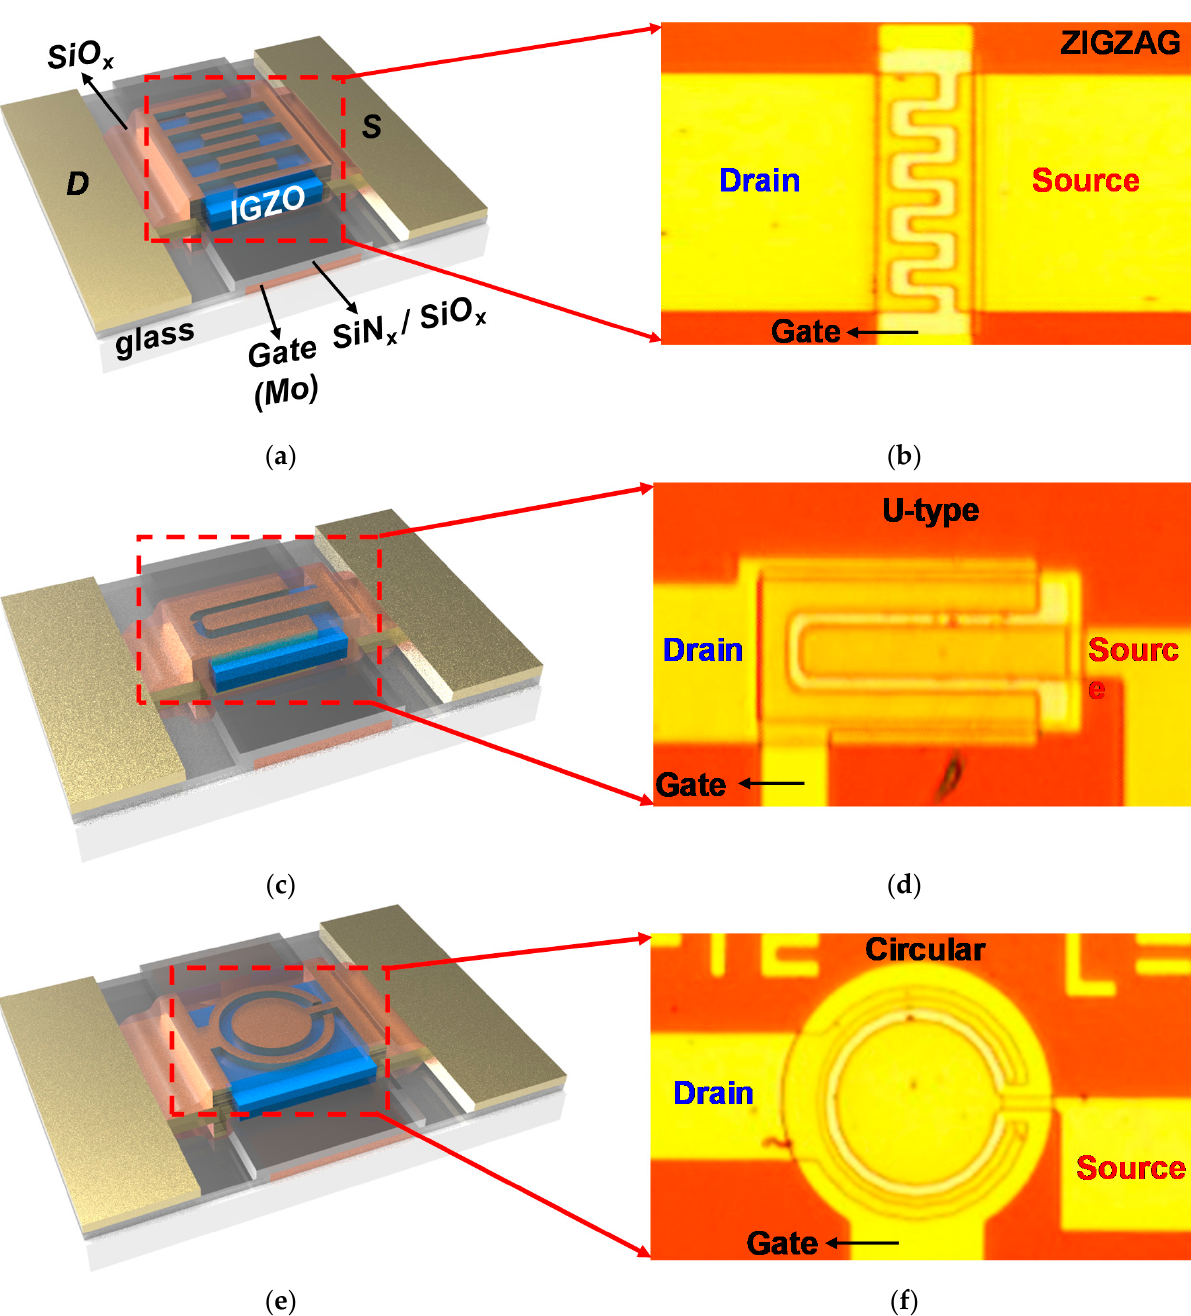
Figure 1. Schematic cartoons for the device configuration corresponding to ( a ) zigzag, ( b ) U-type, and ( c ) circular amorphous indium–gallium–zinc oxide (a-IGZO) thin film transistors (TFTs) and their optical microscope images for the implemented ( d ) zigzag, ( e ) U-type, and ( f ) circular a-IGZO TFTs, respectively.